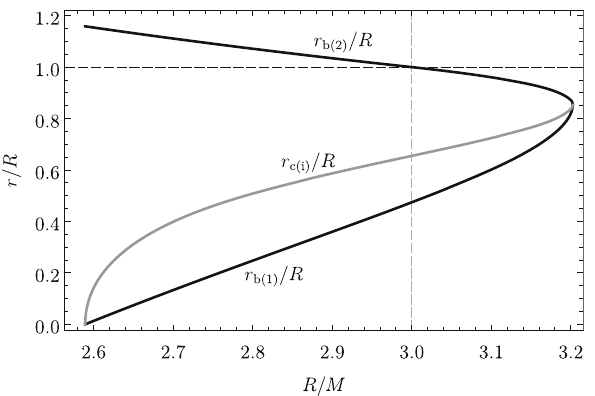
Fig. 3 Region of trapping of null geodesics in extremely compact Tol- man VII spacetimes. Significant radii r b ( 1 ) , r b ( 2 ) and r c ( i ) governing the trappingregionaregiveninrelationtotheparameter R / M oftheobject. The profiles are related to the object radius R . Note that for objects with R / M < 3 there is r b ( 2 ) / R > 1 as the unstable circular null geodesic is located outside the object, while it is inside for R / M > 3